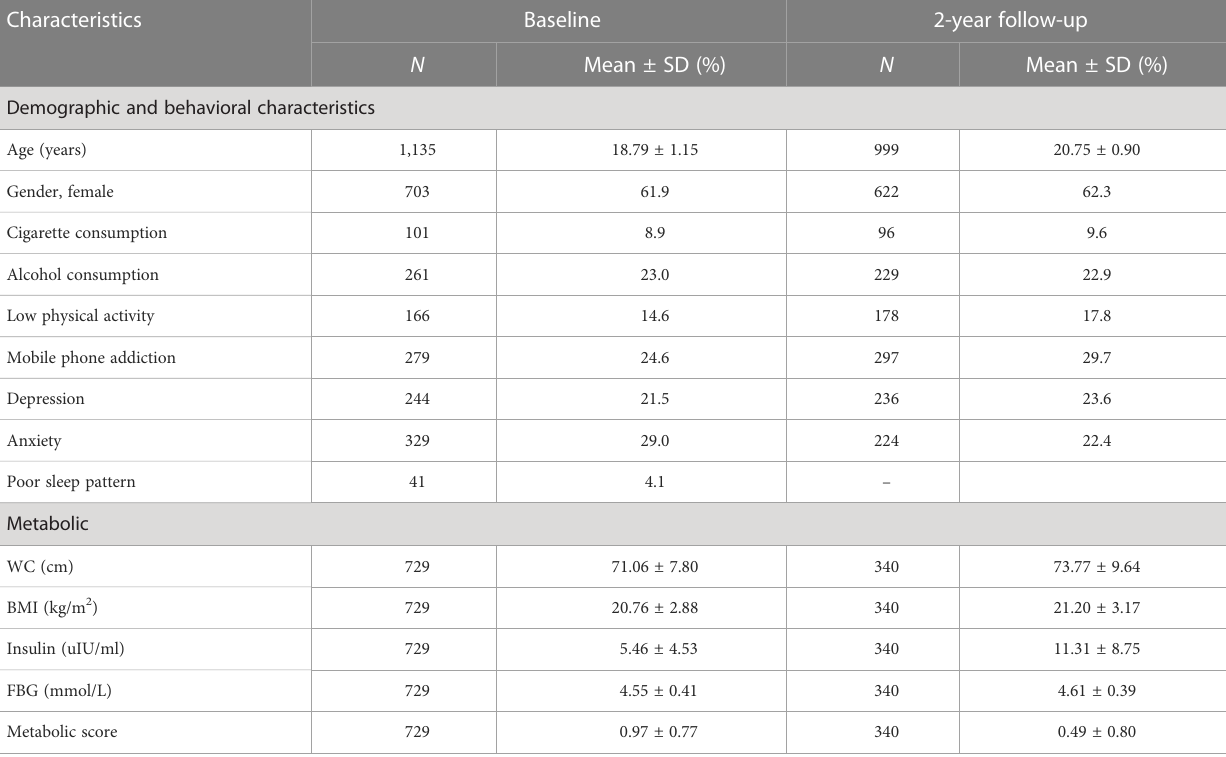
TABLE 1 Descriptive statistics of demographic, behavior characteristics, and metabolic parameters.